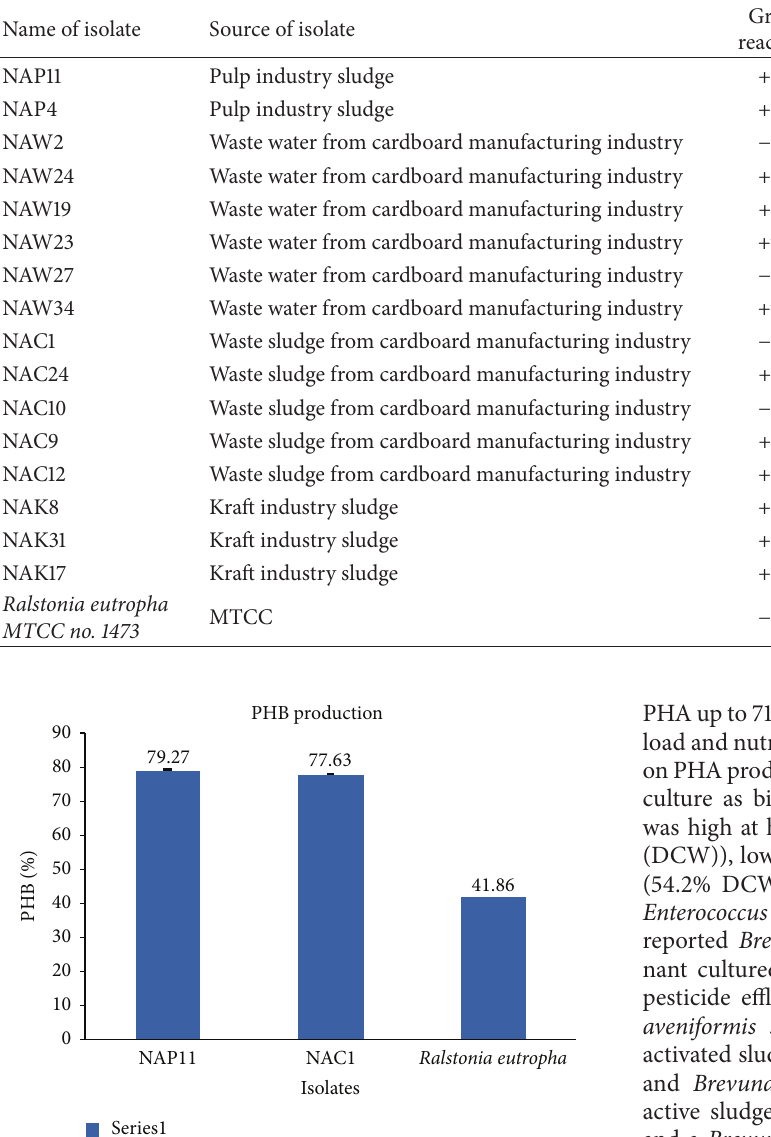
Figure 2: Comparison of PHB production from selected isolates with Ralstonia